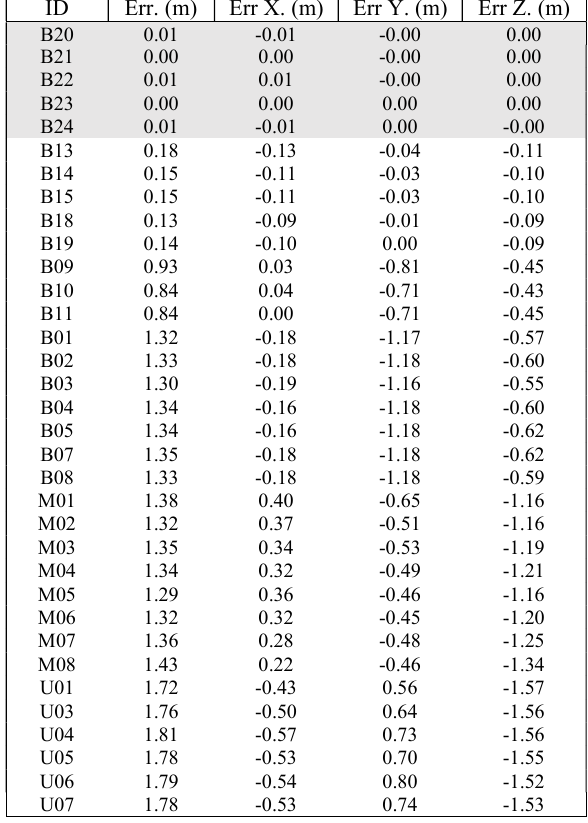
Table 1 . Drift error evaluation, errors on ground control points (grey) and checkpoints.